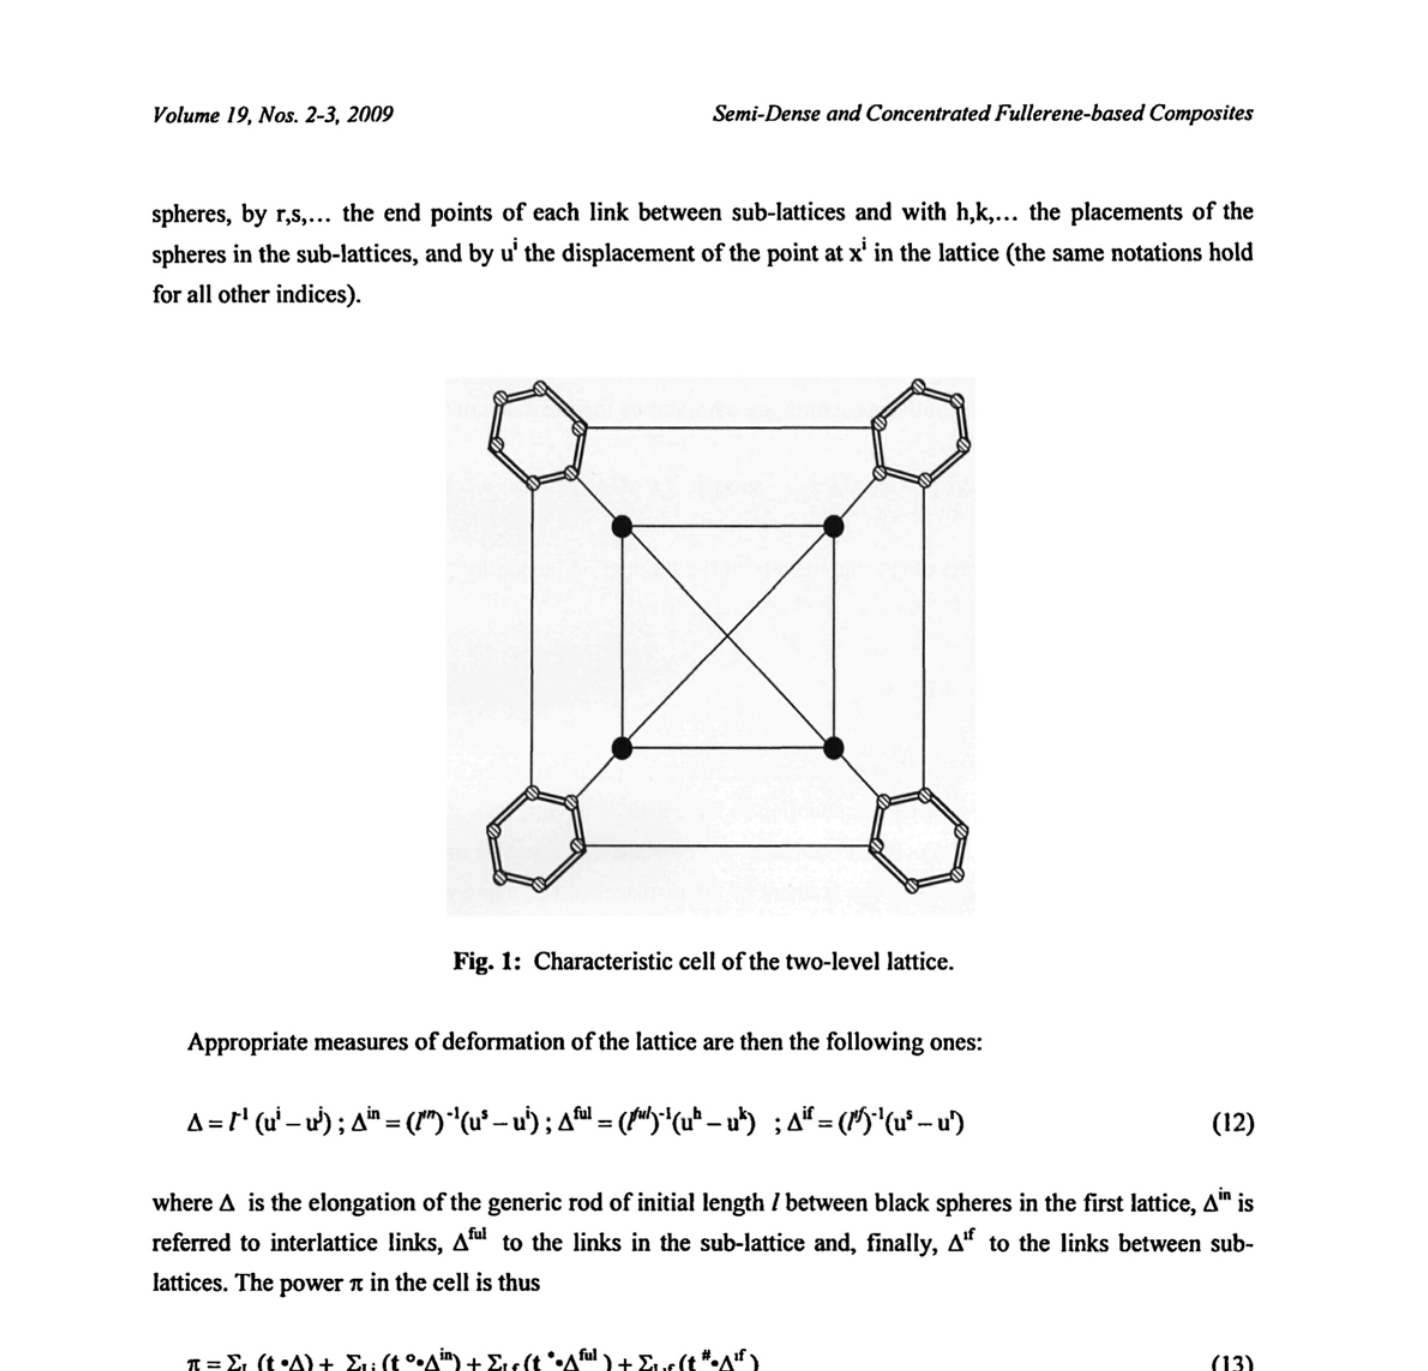
Fig. 1: Characteristic cell of the two-level